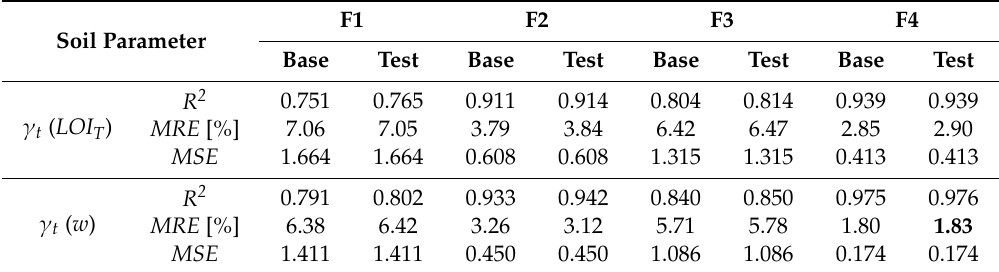
Table 3. The goodness of fit for regression of the one variable